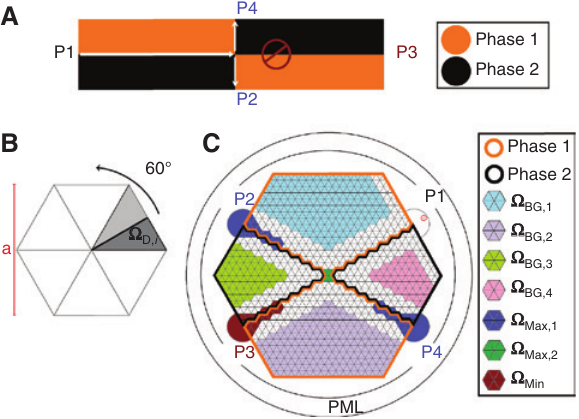
Figure 1: Crystal symmetry and design problem configuration. (A) Illustration of the expected transmission for a photonic topological insulator (PTI) in our design-domain topology. Light impinging from P1 reaches a crossing between the different crystal phases; at the crossing, light cannot propagate forward but can only scatter to the left or right. (B) Symmetry constraints for a single unit cell, which in both phases is restricted to C 6 ν